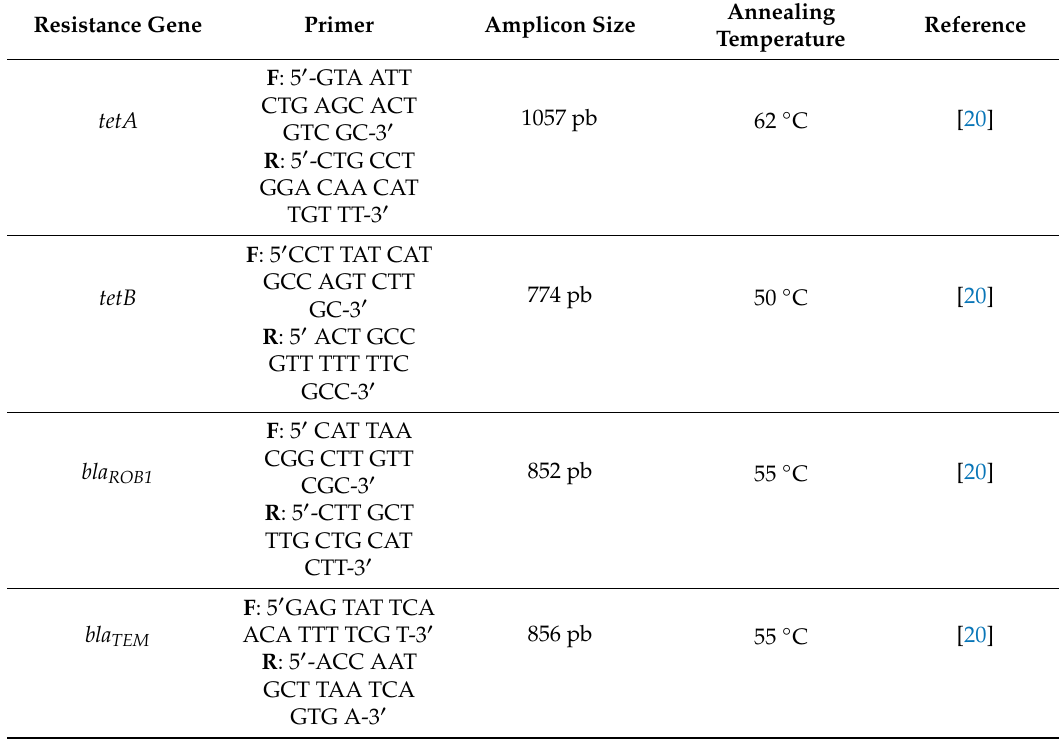
Table 6. Pimers used in the PCRs carried out for the detection of eight antimicrobial resistance genes in 48 Pasteurella multocida